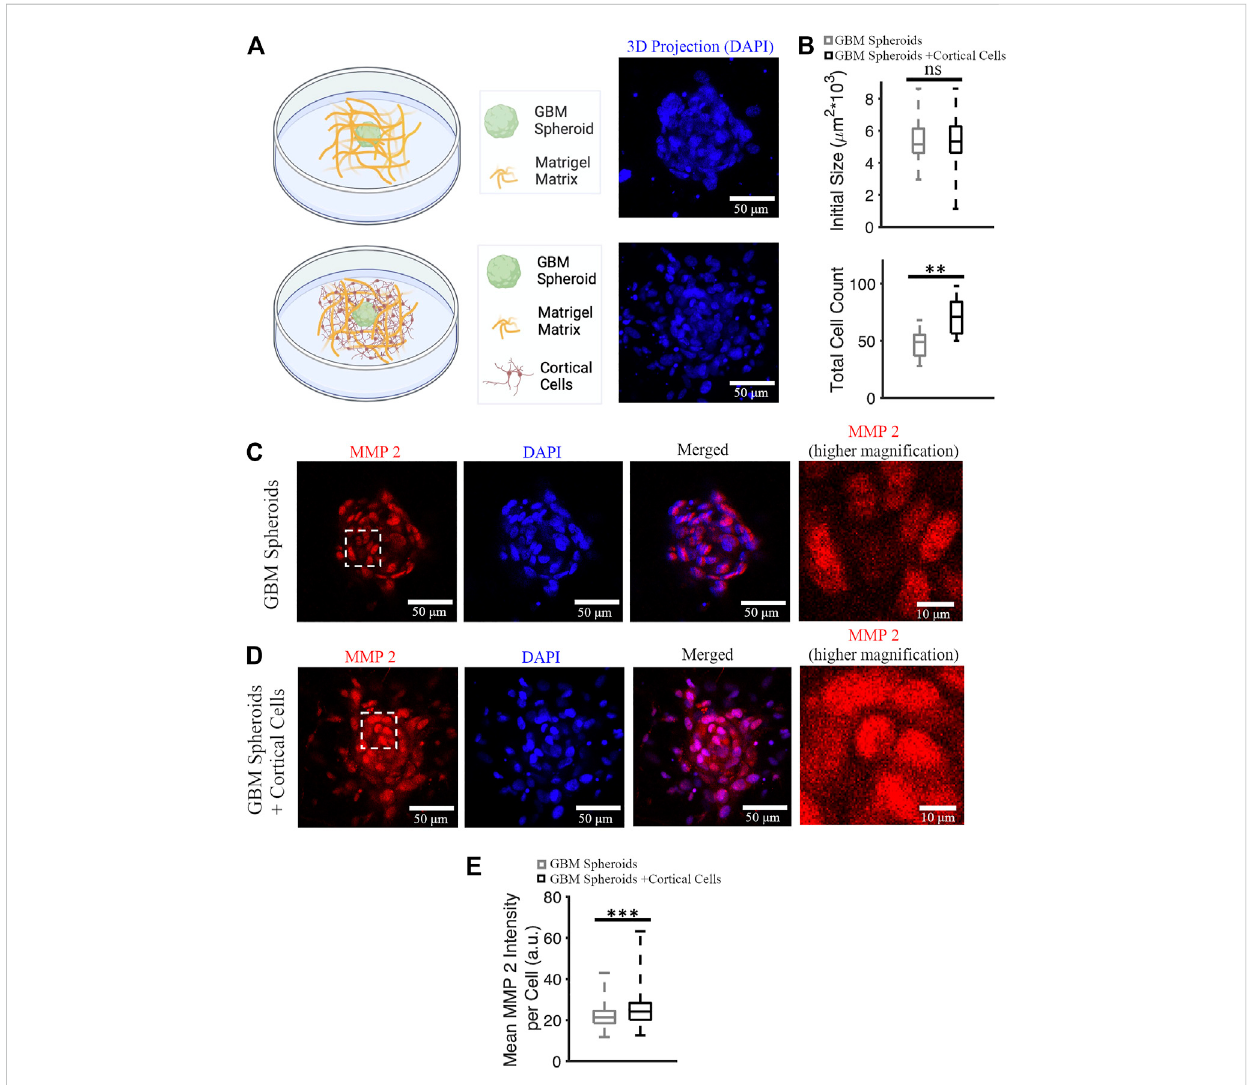
FIGURE 6 MMP 2 expression in GBM spheroids with and without cortical cells. (A) Schematic diagrams and 3D DAPI projections of a GBM spheroid with and without cortical cells embedded in Matrigel matrix. (B) Initial size and total cell count of the GBM spheroids with and without cortical cells. N = 38 and 15GBMspheroids ineachgroupfor initialsize andtotalcell count quanti fi cation,respectively. (C) MMP2 antibodystainingofaGBMspheroid. Thehigher magni fi cation image on the right shows the area bounded by dashed white box in higher detail. (D) MMP2 antibody staining of a GBM spheroid co- culturedwithcorticalspheroidinMatrigel. (E) BoxplotofthemeanMMP2intensitypercellofGBMspheroidswithandwithoutcorticalcells.N=340cells from34GBMspheroidsineachgroup.KStestwasusedtomeasurestatisticalsigni fi cance.** p < 0.01and*** p < 10 – 8 ,ns:notsigni fi cant.Scalebar:50 μ m in all panels except the inset (10 μ